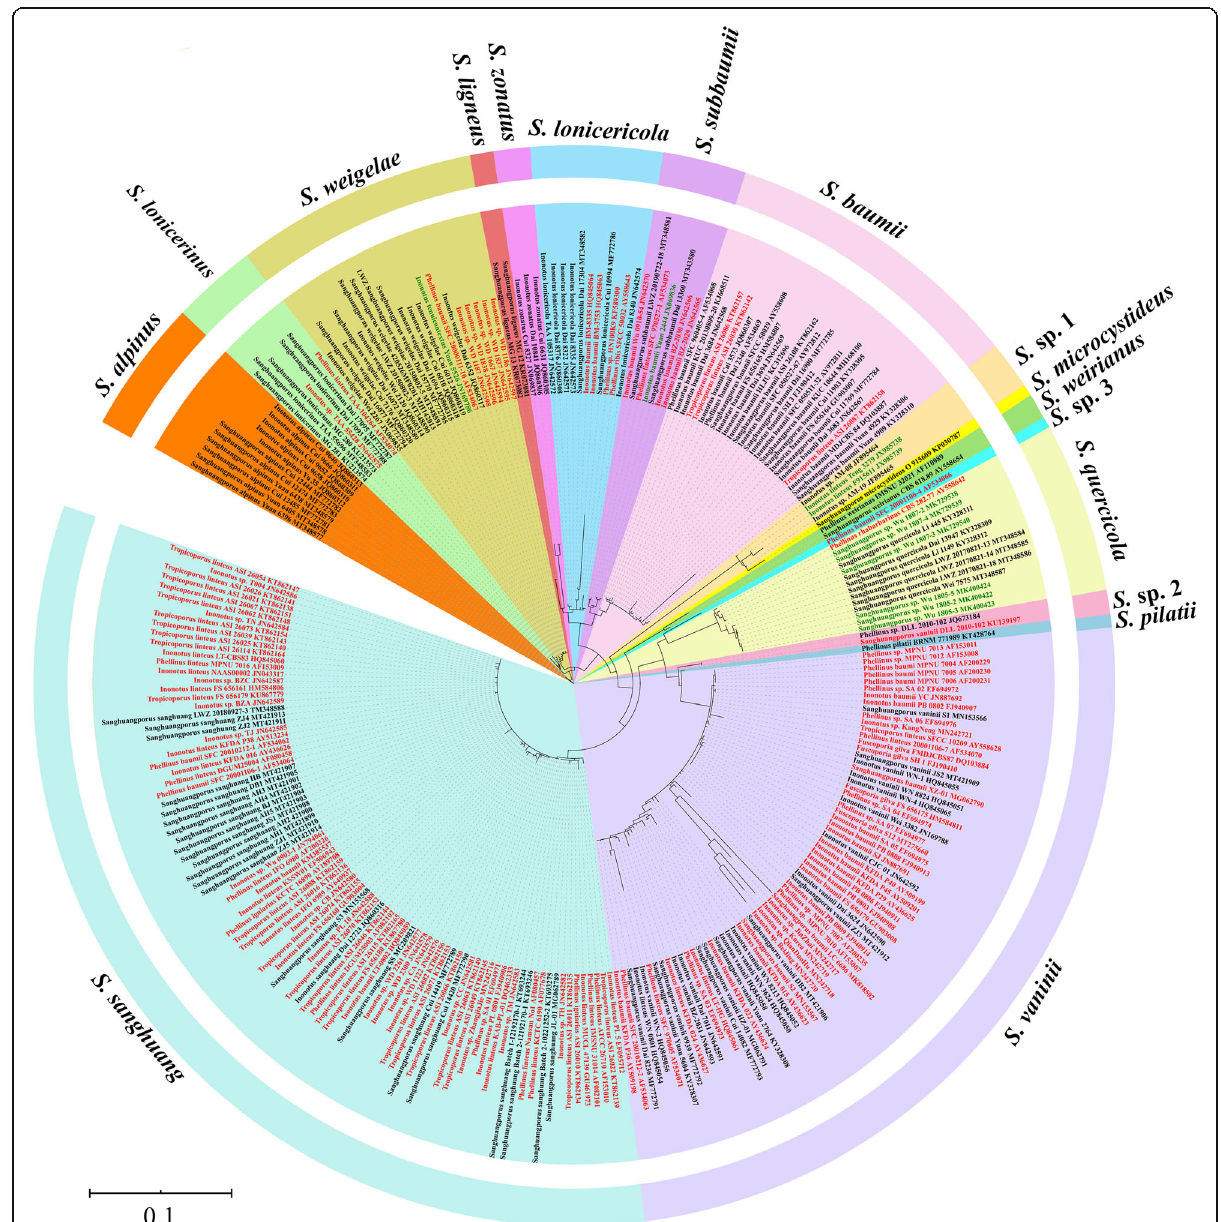
Fig. 1 The phylogenetic tree inferred from 269 ITS sequences. The topology was generated from the maximum likelihood algorithm. The tips in green represent mislabeled specimens, while those in red represent mislabeled